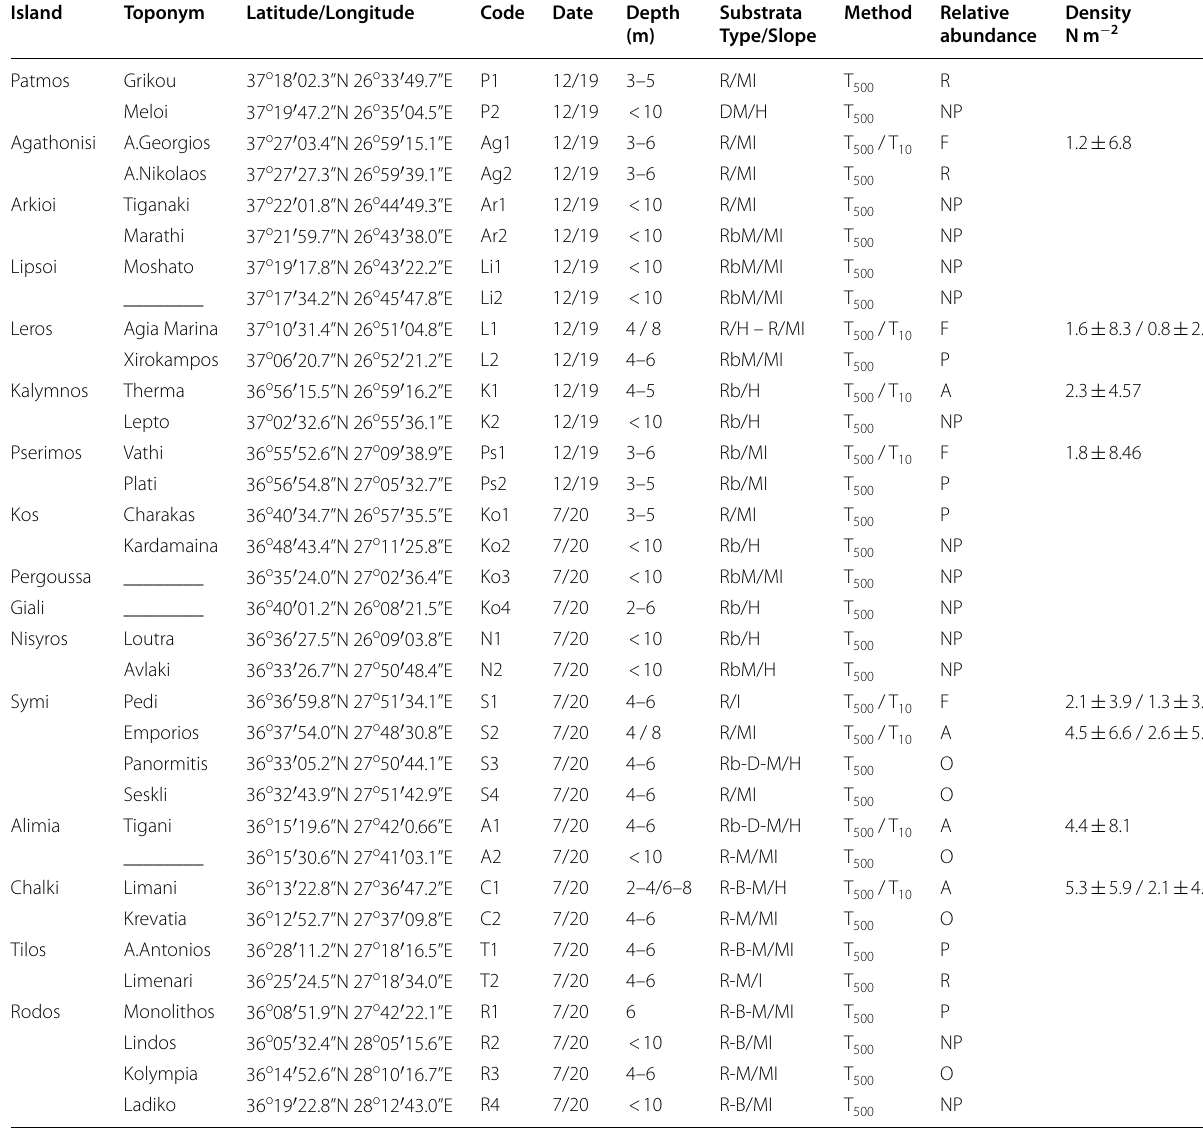
Table 1 Location, code and geomorphological characteristics [depth, substrate type (R M meadows), slope (H = complex (south Aegean